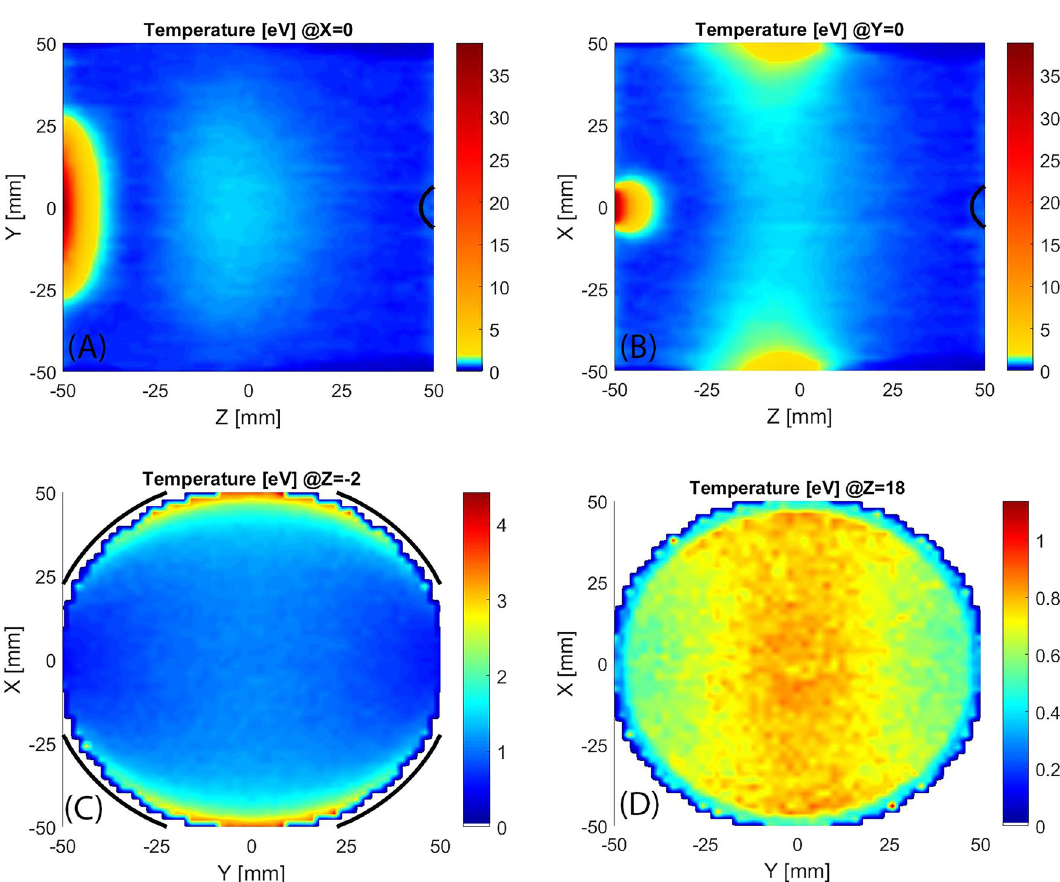
Figure 6. Longitudinal slices ( A , B ) and transversal slices ( C , D ) of evaluated electron temperature spatial distribution, black line marks the ECR